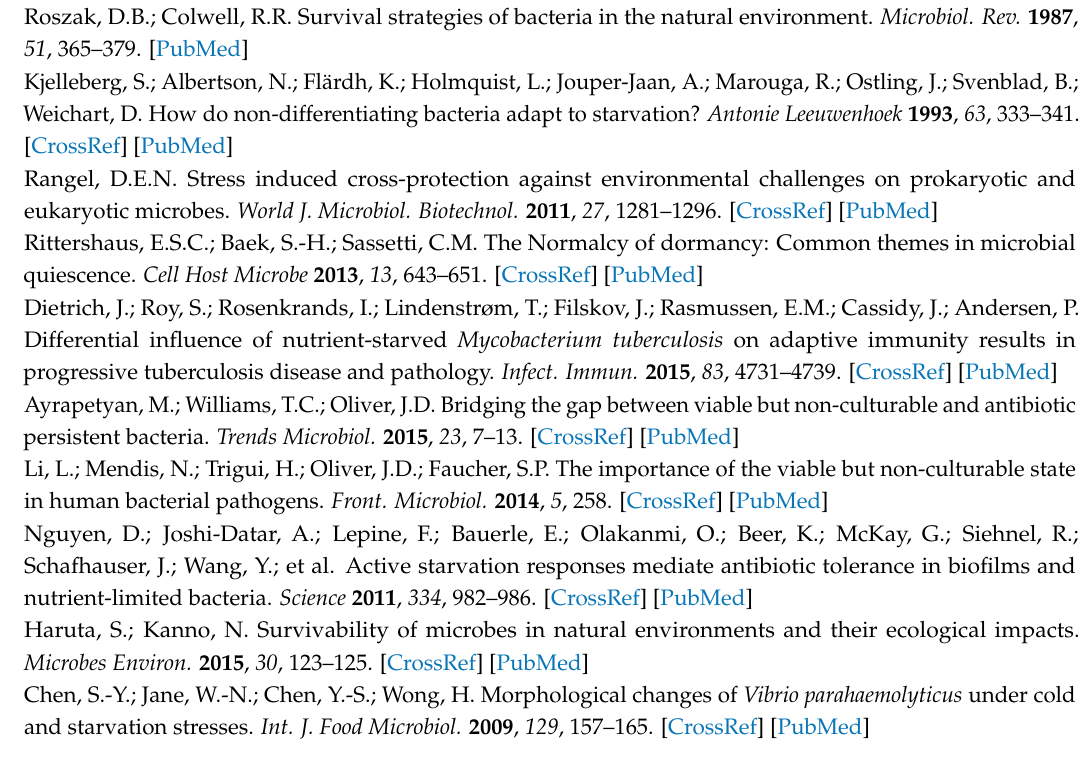
Figure S1: Phototrophic growth of R. palustris CGA009 in the carbon-limited medium. Acknowledgments: We thank Nina R. Salama (Fred Hutchinson Cancer Research Center) for valuable discussion and Shigeki Ehira (Tokyo Metropolitan University) for helpful comments on the manuscript. We are grateful to Donald Anderson for critical reading of the manuscript and English